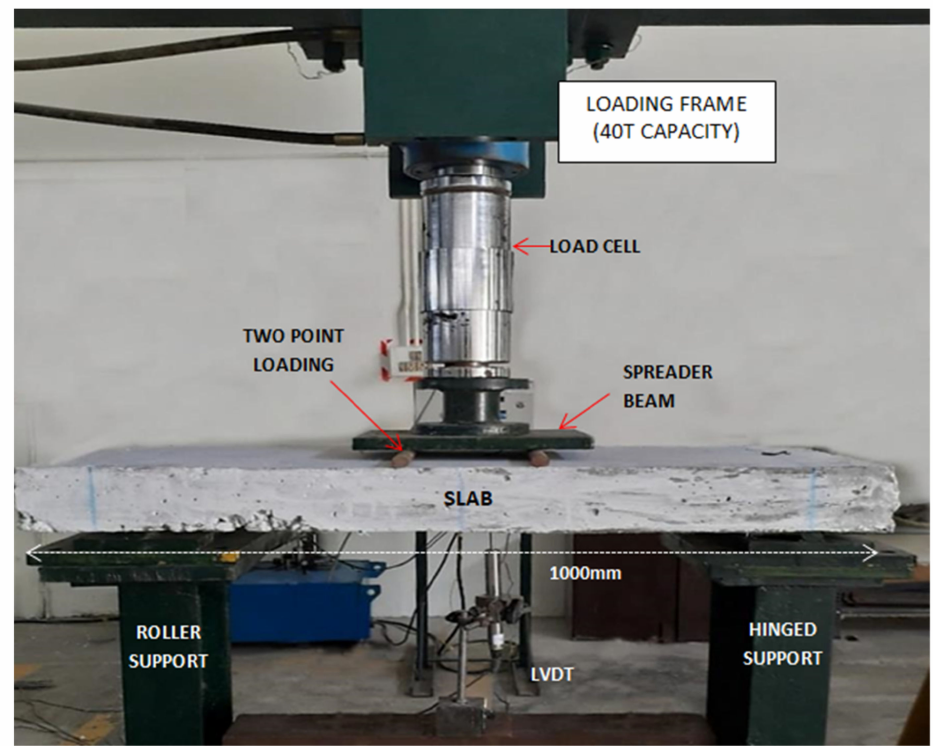
Figure 2. Experimental setup.